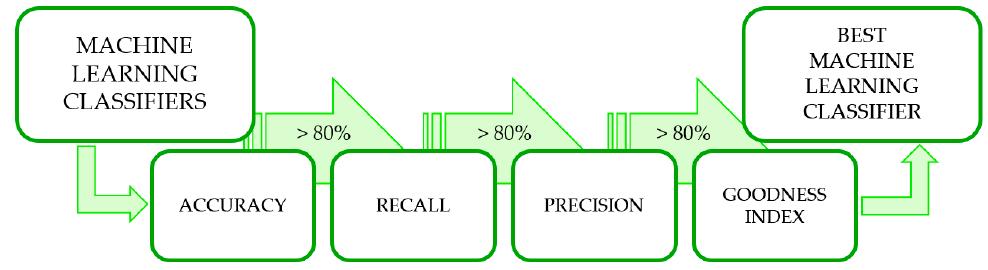
Figure 2. Flow chart for the identification of the best-performing